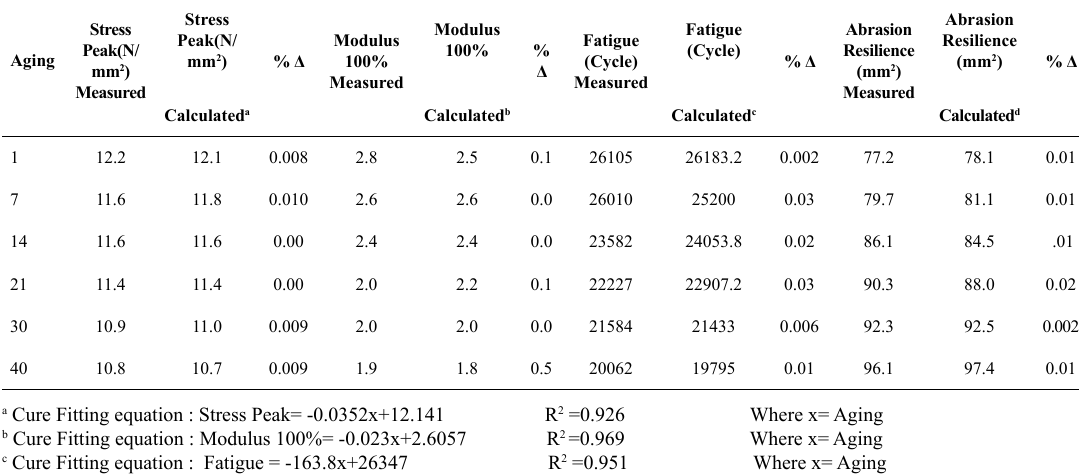
Table 9. Comparison of measured and calculated data of TC